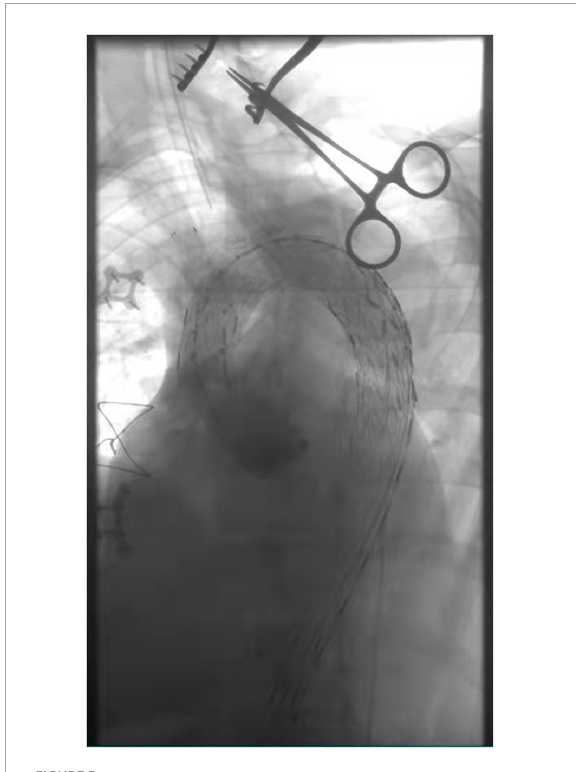
FIGURE5 The three branches of the aortic arch were well displayed, and the IA, LCA, and LSA were reconstructed with in situ fenestration.